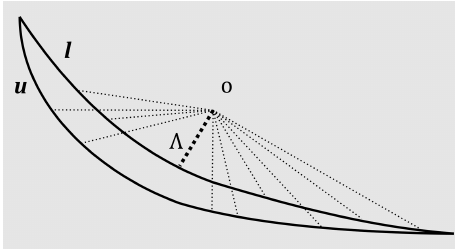
Figure A3. Sketch of how (cid:51) is determined with Eq. (1) for a 2-D example. The circle represents the location of the observation. l and u are the isosurfaces of the lower and upper bounds respectively. The thick dotted line represents the minimum Euclidean distance to an isosurface bound, (cid:51) . The thinner dotted lines are some other Euclidian distances.